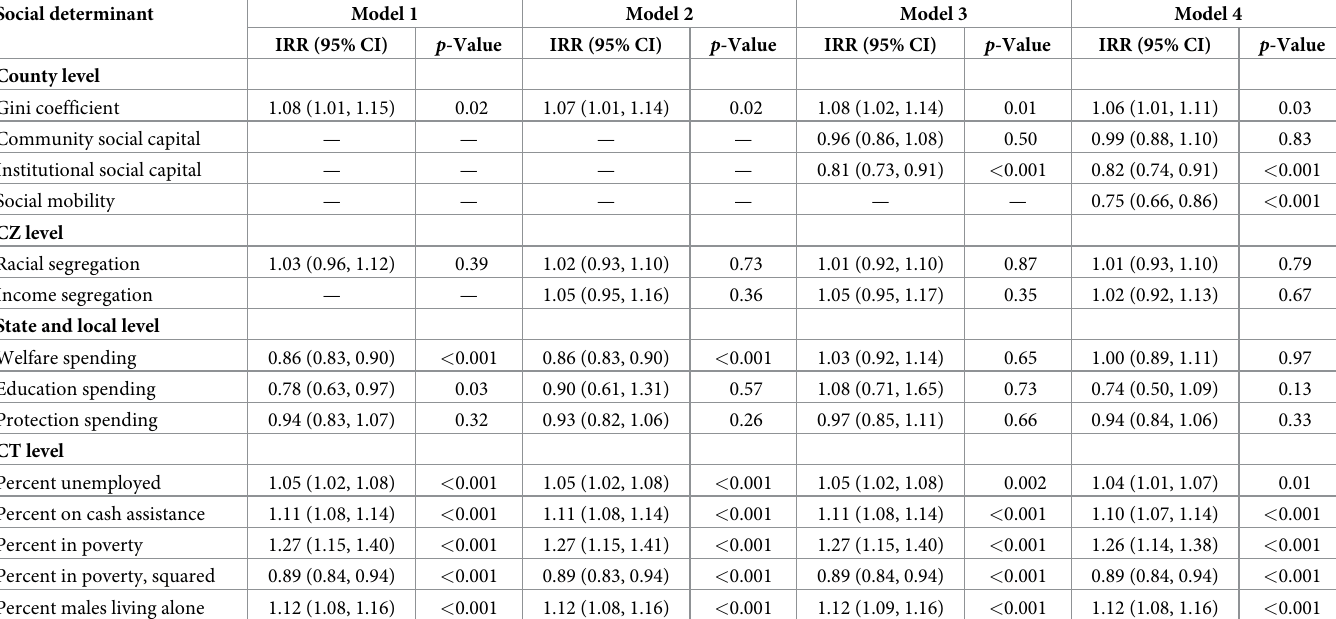
Table 1. Social determinants and risk of firearm-related homicide at the CT level in the contiguous US, 2015. Social